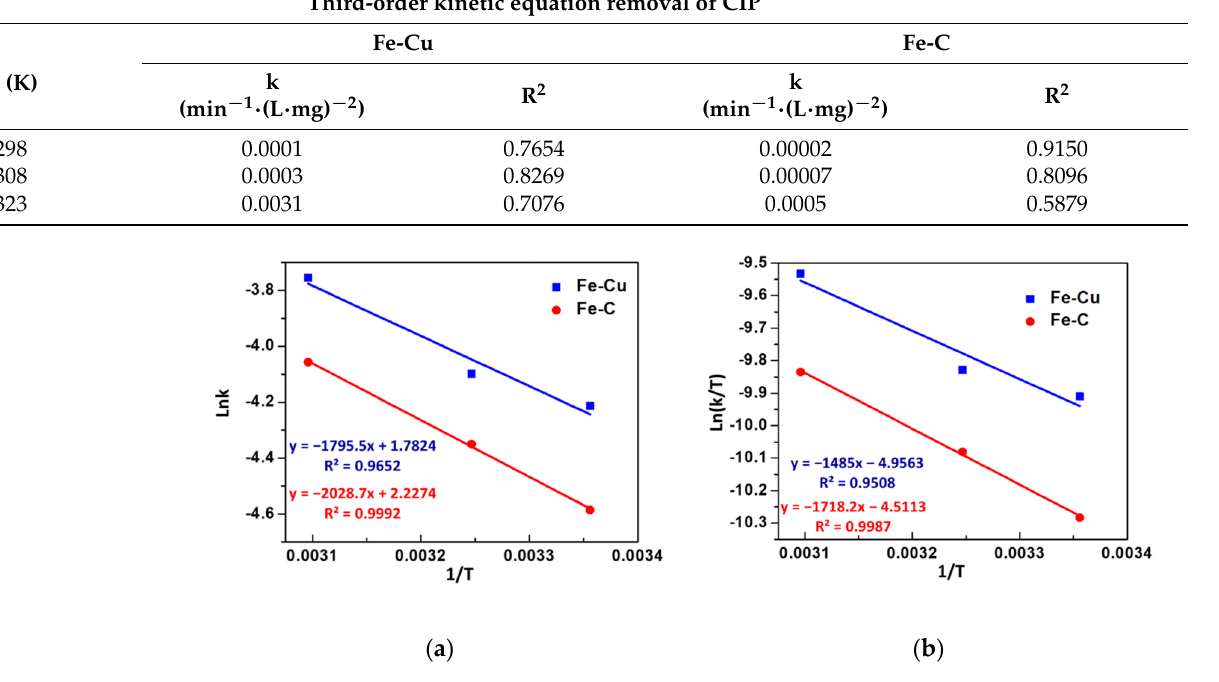
Figure 9. ( a ) Relationship between lnk and 1/T; ( b ) Relationship between ln(k/T) and 1/T.